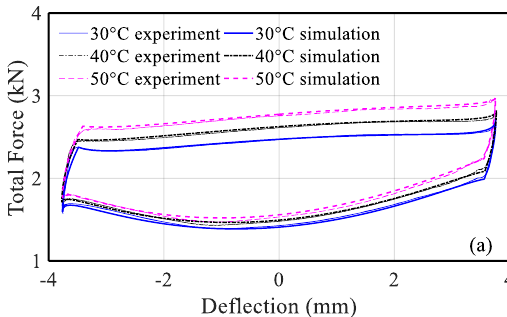
Figure 5. Comparisons of experimental and simulated total force-deflection ( a ) and total force-velocity ( b ) relationships at different temperatures (2 Hz).